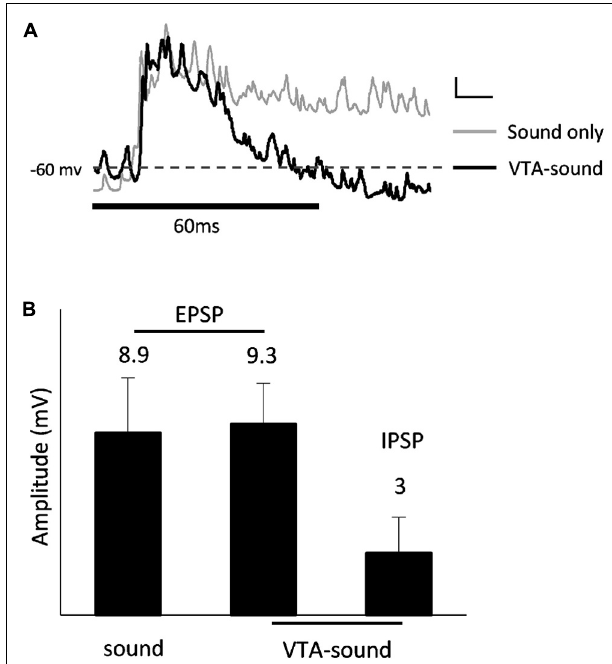
FIGURE 5 | IPSP after excitatory auditory response. (A) Averaged membrane potential from 13 recorded neurons (sound only group: gray; pairedVTA-sound group: black).Thick black bar indicates the sound stimulation. Dashed line shows the level of averaged resting membrane potential. Scale bar: 1 mv/10ms. (B) 8 of 13 neurons showed clear hyperpolarization after initial depolarization.The amplitudes of EPSP evoked by two stimulation groups showed no significant difference (sound only: 8.9 ± 2.7 ms; pairedVTA-sound: 9.3 ± 2 ms, p = 0.46, paired t -test). Averaged amplitude of IPSP: 3.0 ± 1.8